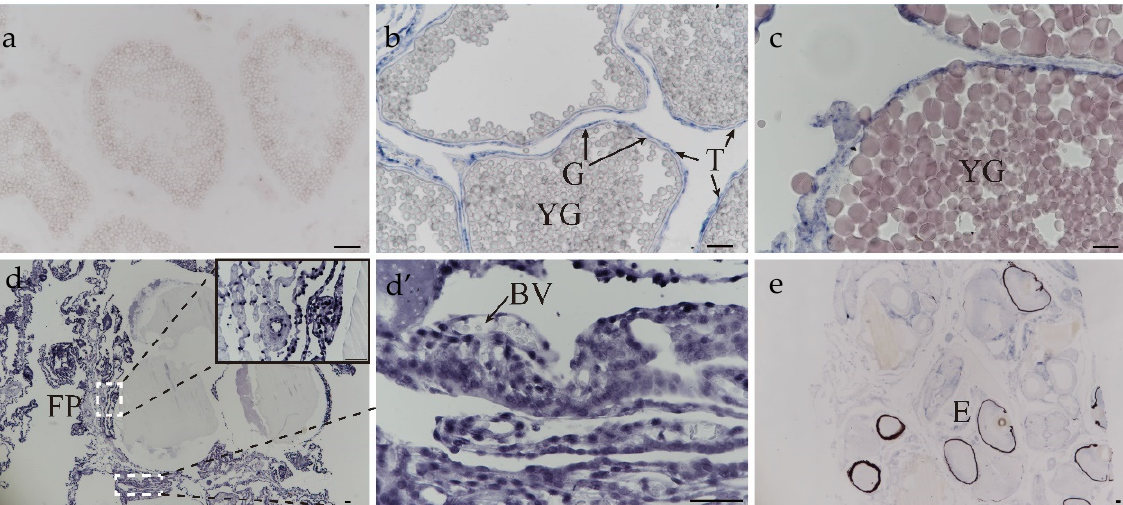
Figure 7. The location of lama4 in ovaries during oogenesis and gestation. ( a ) ovary at stage III; ( b ) ovary at stage IV—YG: yolk globule; T: theca cell; G: granulosa cell; ( c ) ovary at stage V; ( d ) embryos at the blastula stage—B: blastula stage, FP: follicular pseudoplacenta; ( d’ ) follicular pseudoplacenta at the blastula stage—BV: blood vessel; ( e ) embryos at the prehatching stage—E: embryo. scale bar: 50 μ m.